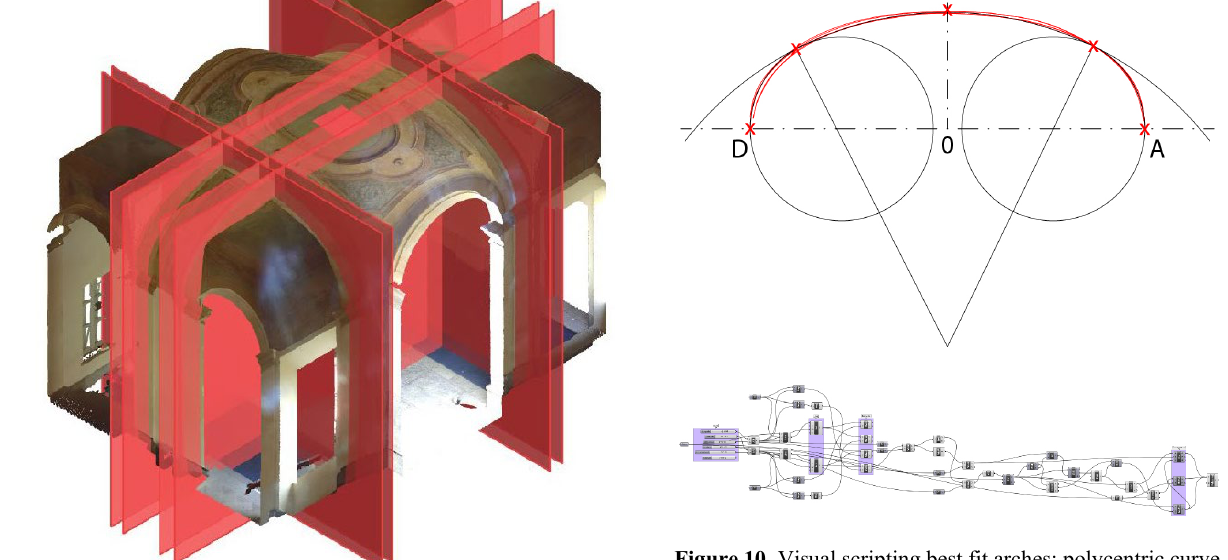
Figure 10 . Visual scripting best fit arches: polycentric curve (Processing: F.